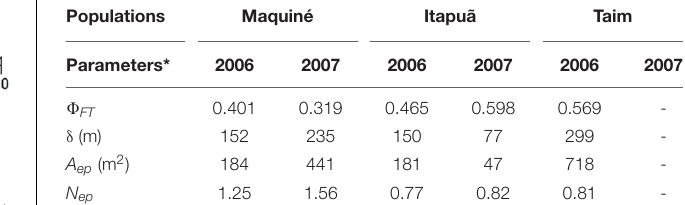
TABLE 5 | Contemporary gene flow parameters of Vriesea gigantea across populations and years.